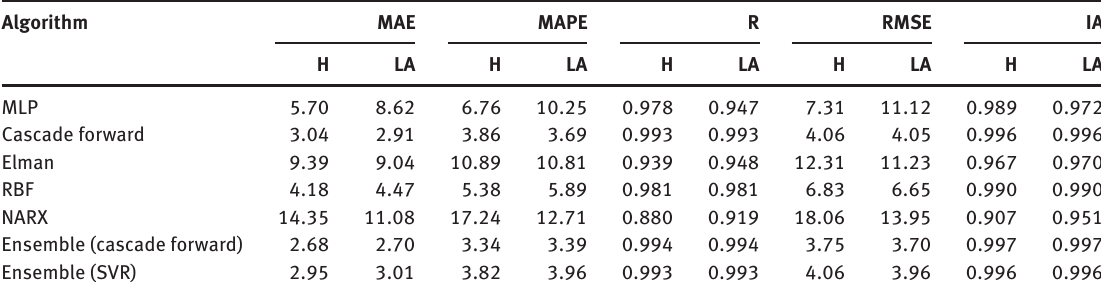
Table 4: Performance of Cascade Forward and SVR Ensembles with Neural Networks as the Base Learners. Algorithm